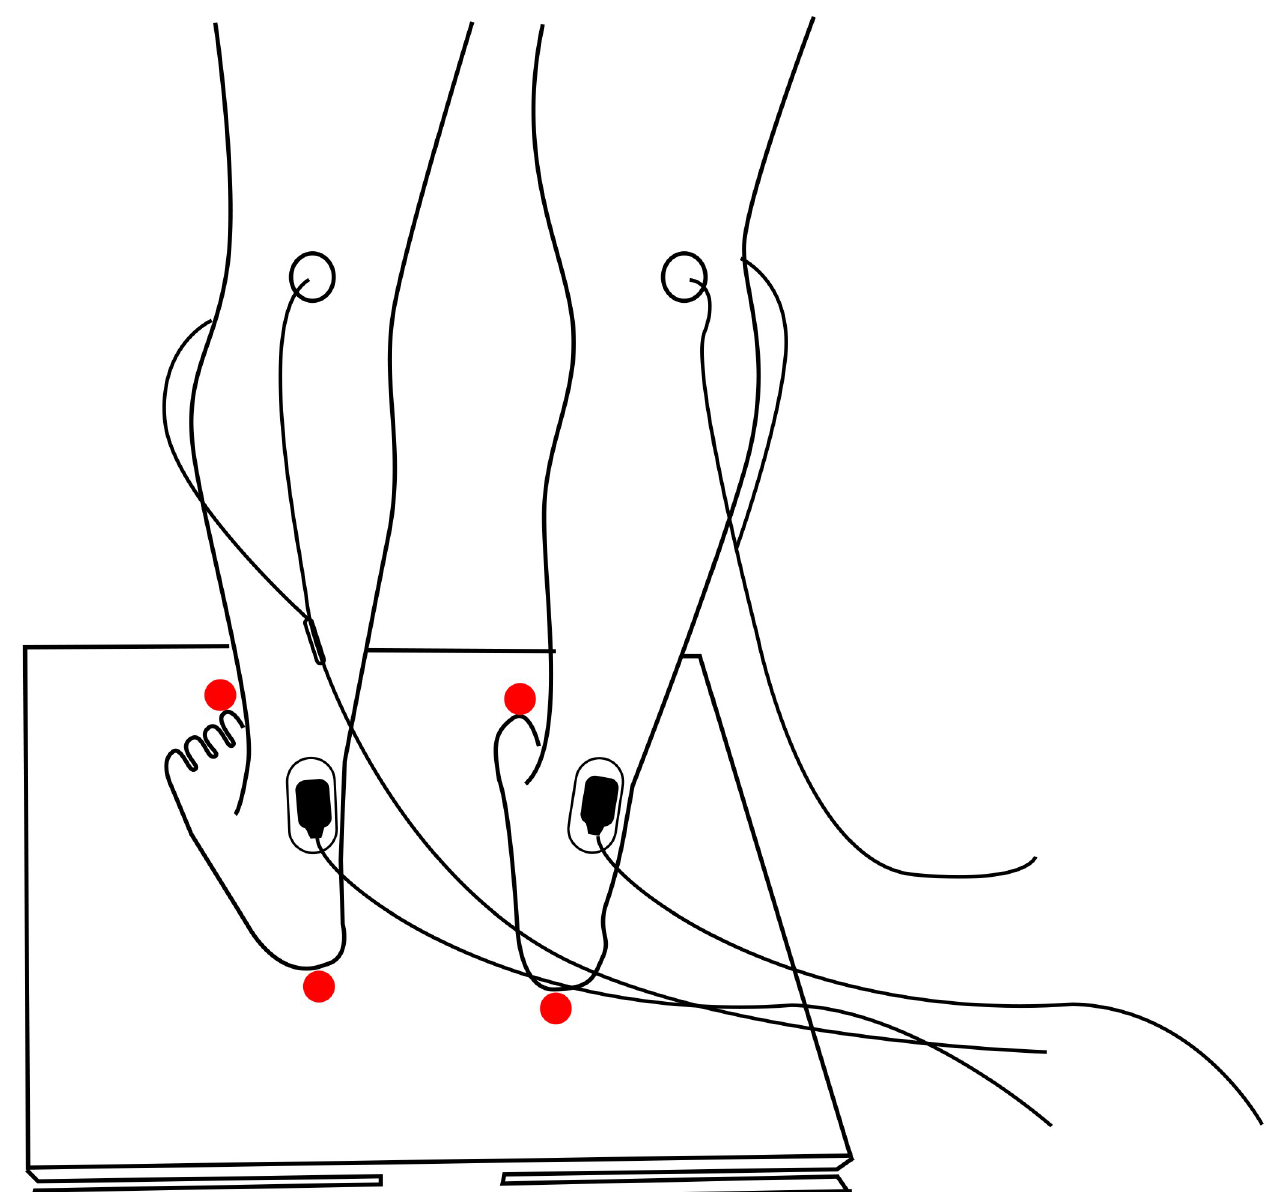
Fig 1. Protocol setup. Stimulation electrodes were placed on the posterior tibial nerve to elicit an M-wave and or H-reflex. The response was recorded by surface electrodes placed on the soleus muscle. The resultant muscle contraction would induce a plantar flexion moment in a closed kinematic chain, causing a perturbation in standing posture. Unilateral or bilateral stimulation would provide sideway or forward perturbations. Red dots represent the places marked for measuring BOS and feet locations.